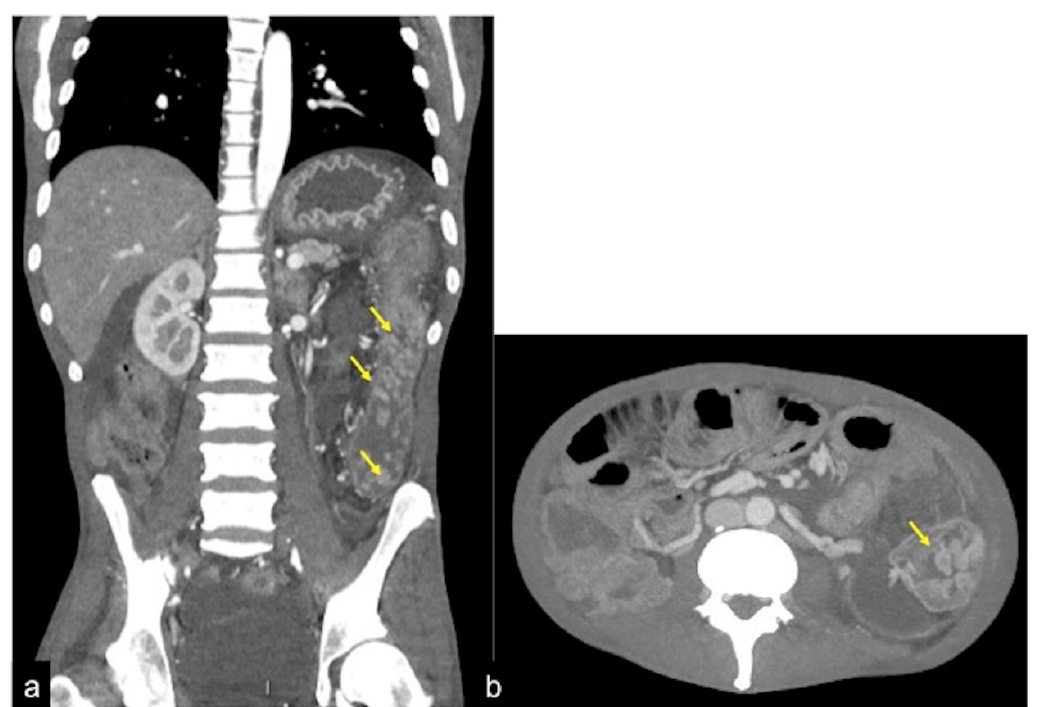
Figure 37. CTA arterial phase ( a ) and relative MIP reconstruction ( b ) of polyposis of the descending colon ( a , b , arrows).